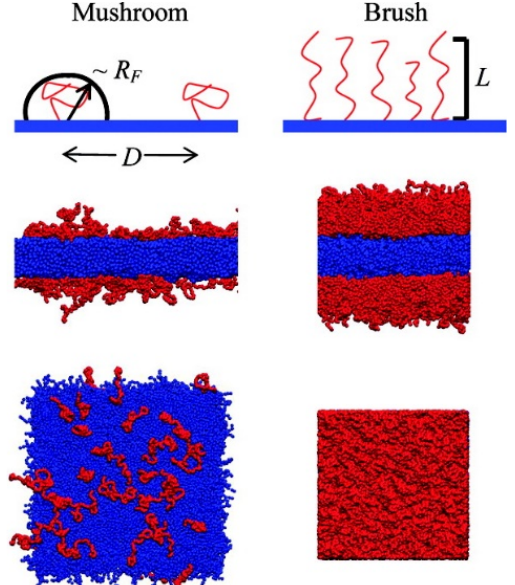
Figure 5. Schematic illustrations of the mushroom and brush conformations ( top ), and snapshots of the side ( middle ) and top-down ( bottom ) views at the end of simulations of PEG chains grafted on a hydrophobic surface (reprinted with permission from [25]. Copyright (2009) American Chemical Society).